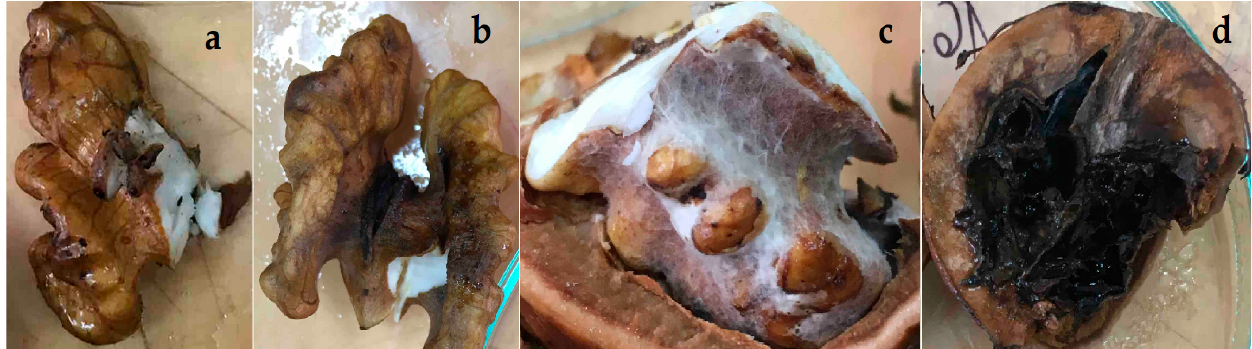
Figure 3. Symptoms on kernels and the classification of the progress of necrosis three weeks after inoculation onto a freshly inflicted wound of the husk. ( a ) 0—symptomless fruits; ( b ) 1—discoloured kernel; ( c ) 2—kernel covered with mycelium; ( d ) 3—entirely rotten nuts.